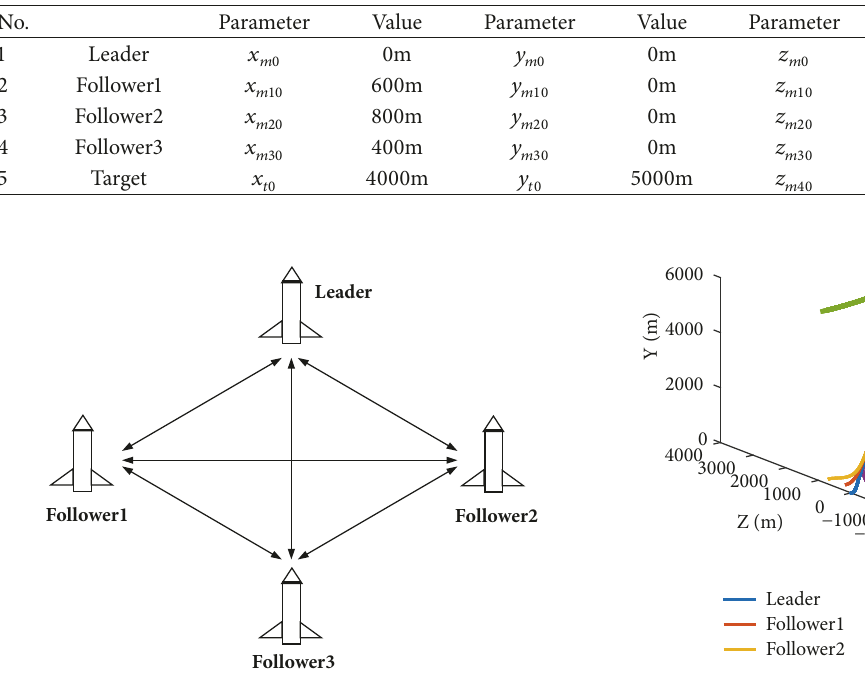
Figure 3: Motion trails of the interceptor “leader,” “follower,” and target in the global communication topology: X denotes the horizontal motion trail of the interceptor and target, Y denotes the longitudinal motion distance of the interceptor and target, and Z denotes the lateral motion trail of the interceptor and target.